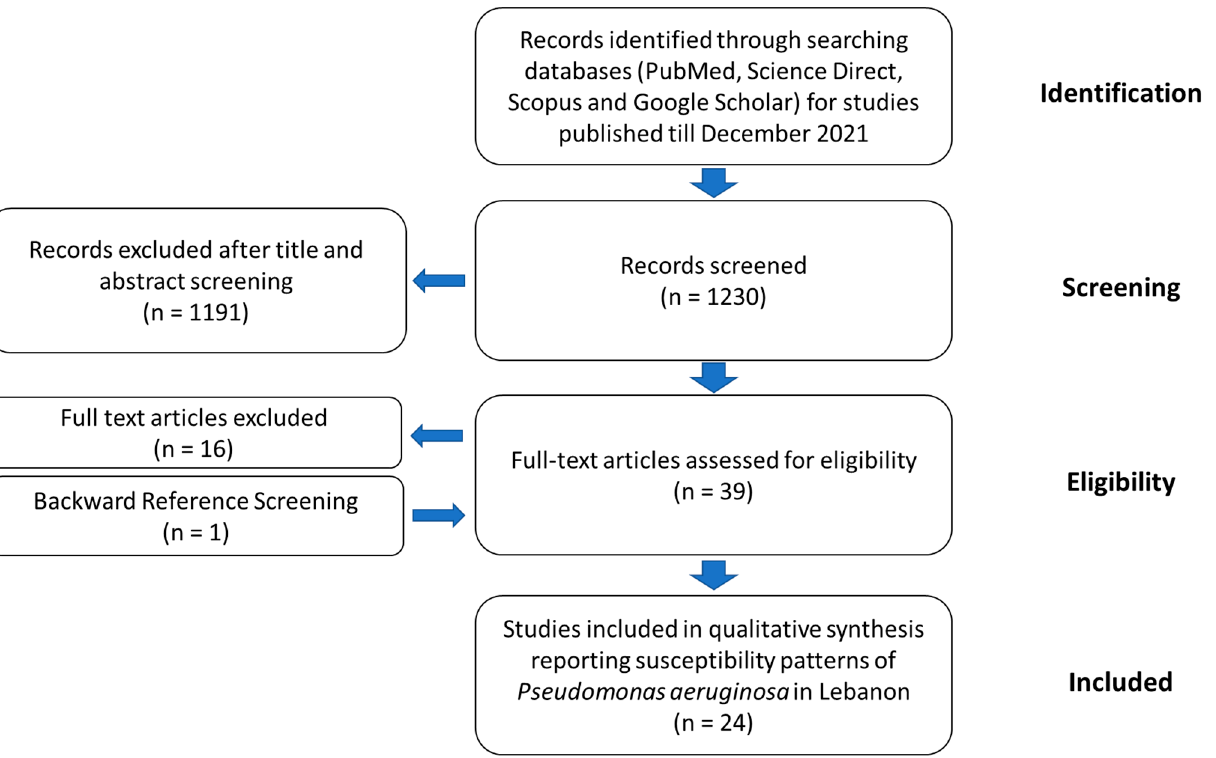
Figure 2. A Flow diagram describing the selection of the studies and the inclusion/exclusion process for the review according to PRISMA guidelines. Table 1. A list of the studies that described the epidemiology of antimicrobial resistant Pseudomonas aeruginosa in Lebanon.